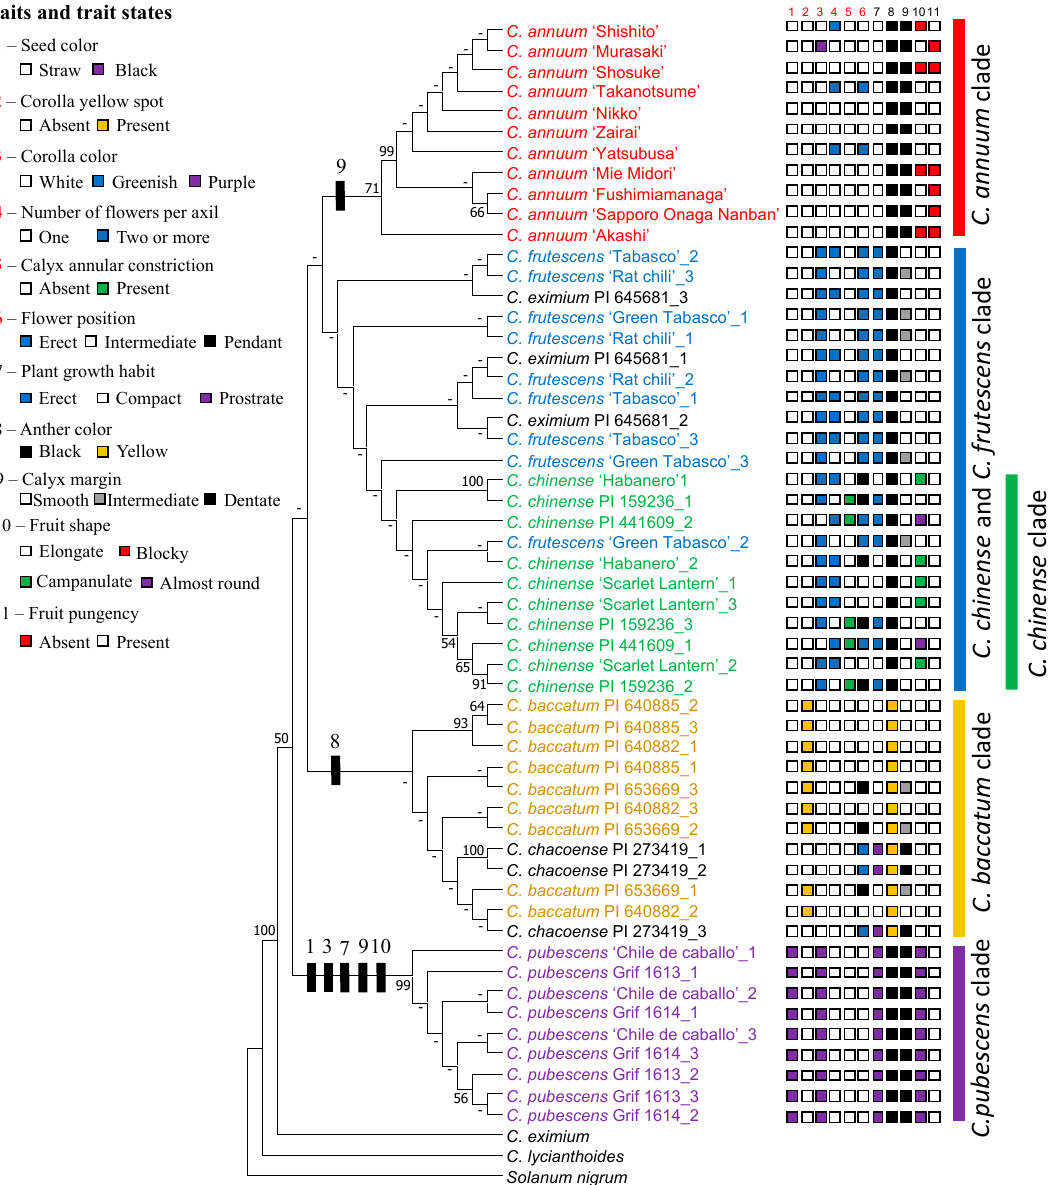
Figure 3. Molecular phylogenetic tree based on a maximum-likelihood analysis of rDNA ITS sequences, and evolution of morphological traits in Capsicum . Bootstrap = 1000 replicates (any clade with a hyphen has a bootstrap < 50). Trait state changes are indicated by black rectangles with the number of the trait on the phylogenetic tree. Traits 1 to 6 (written in red) are the key morphological traits of domesticated species.